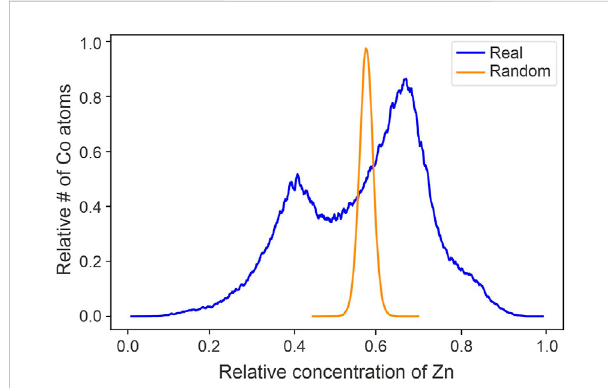
FIGURE 2 Spatial correlation plot of Zn ions surrounding Co ions from the full APT dataset. Two distinct peaks are visible, which is due to the difference in signal on the laser incident side and the off-laser side of the APT